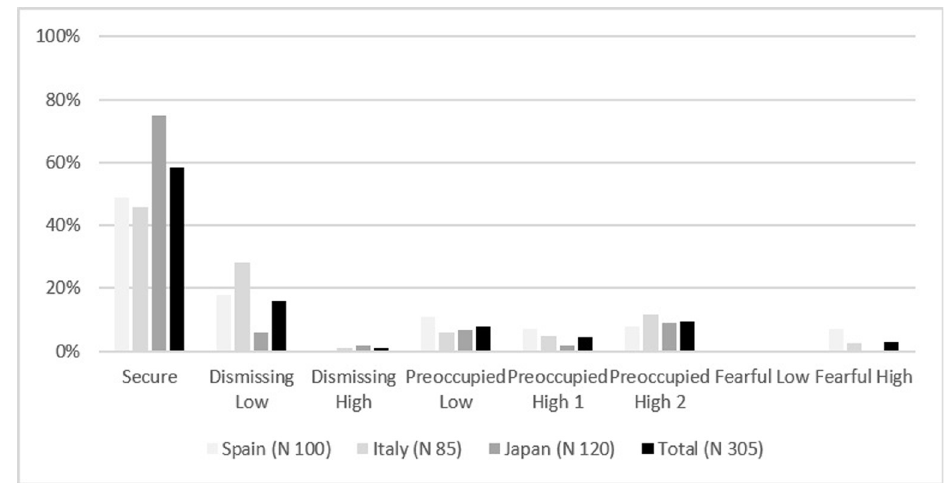
Fig 3. Paternal bonding frequencies among groups (PBI-Father